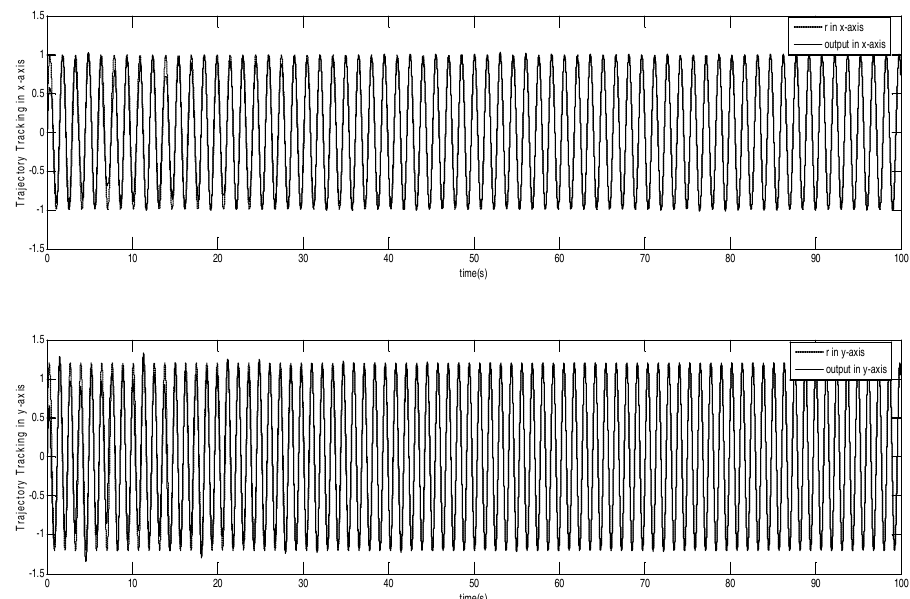
Figure 3. Trajectory tracking using adaptive dynamic sliding mode control based on the backstepping approach.